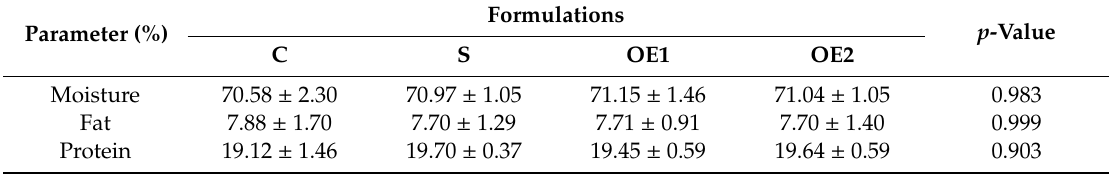
Table 1. Proximate composition of the beef patties at Day 0 (mean values ± standard deviations). Formulations p -Value Parameter (%) C S OE1 OE2 Moisture 70.58 ± 2.30 70.97 ± 1.05 71.15 ± 1.46 71.04 ± 1.05 0.983 Fat 7.88 ± 1.70 7.70 ± 1.29 7.71 ± 0.91 7.70 ± 1.40 0.999 Protein 19.12 ± 1.46 19.70 ± 0.37 19.45 ± 0.59 19.64 ± 0.59